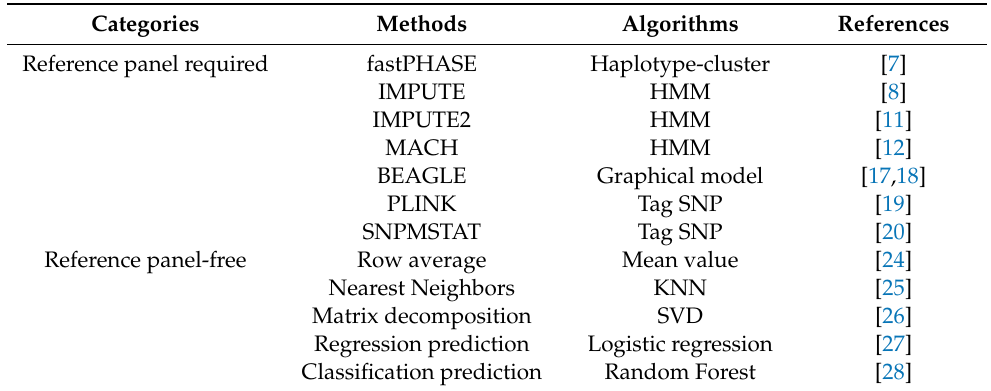
Table 1. Summary of existing genotype imputation methods. HMM, hidden Markov model; SNP, single nucleotide polymorphism; KNN, k-nearest neighbors; SVD, singular value